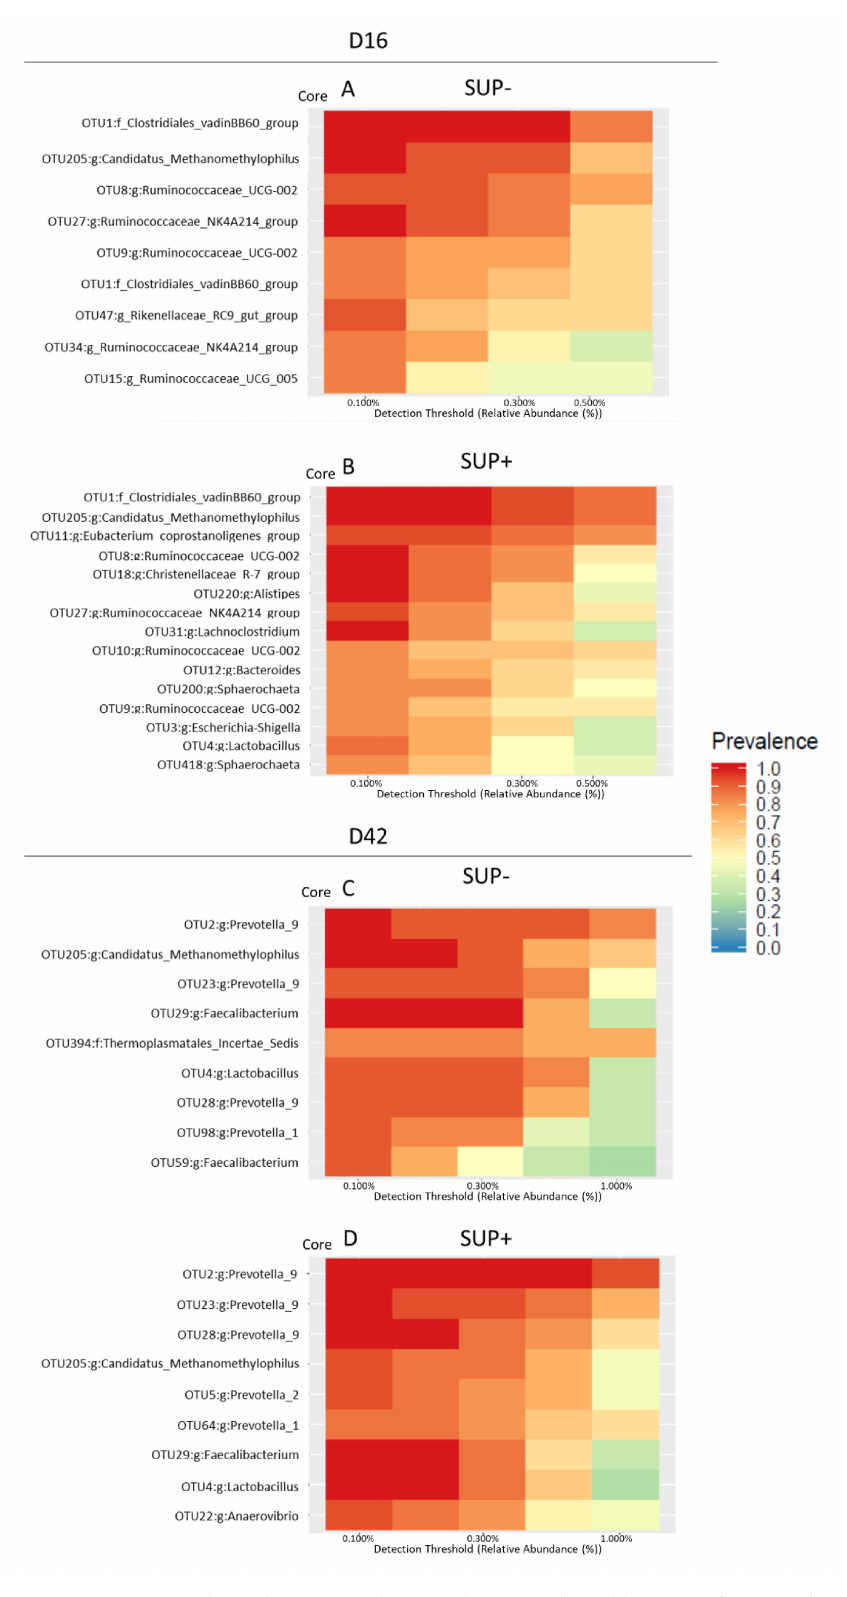
Figure 3. Core microbiota heatmaps showing bacteria shared by 80% of unsupplemented piglets (SUP − ) or piglets supplemented (SUP+) at birth with a mixture of probiotics, prebiotics, immunoglob- ulins, vitamins, and selenium at Day 16 of age ( A , B ) and two weeks post-weaning ( C , D